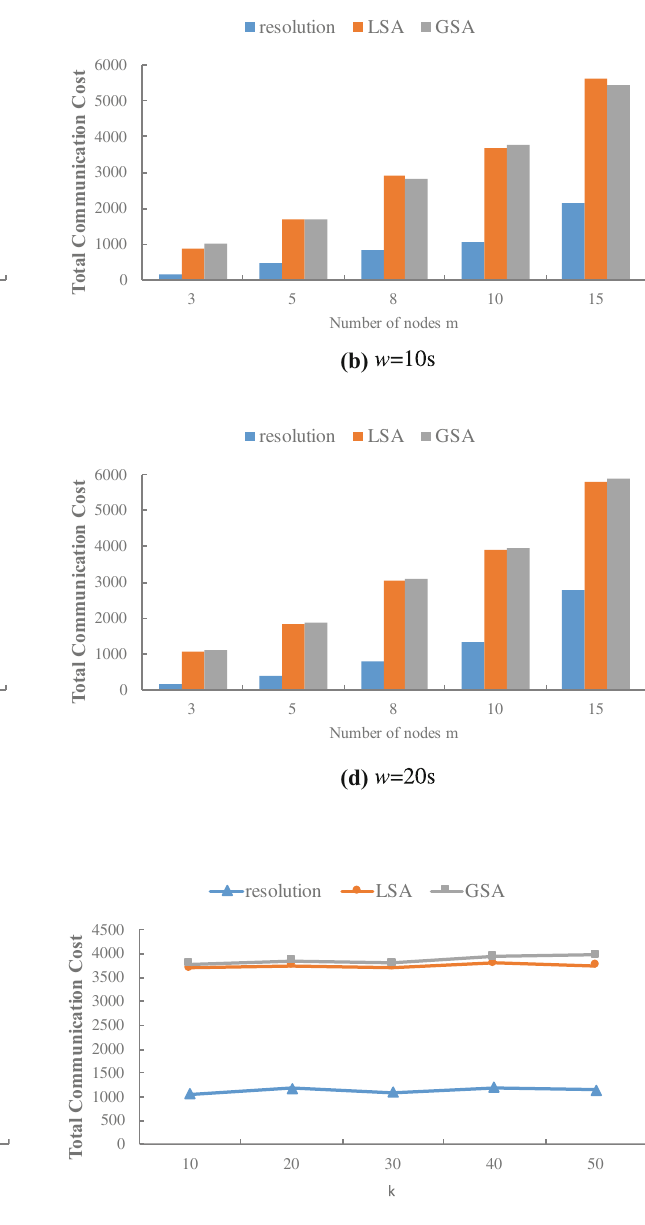
Fig. 6 Varying approximation parameter e using real dataset, w ¼ 10s, m ¼ 10